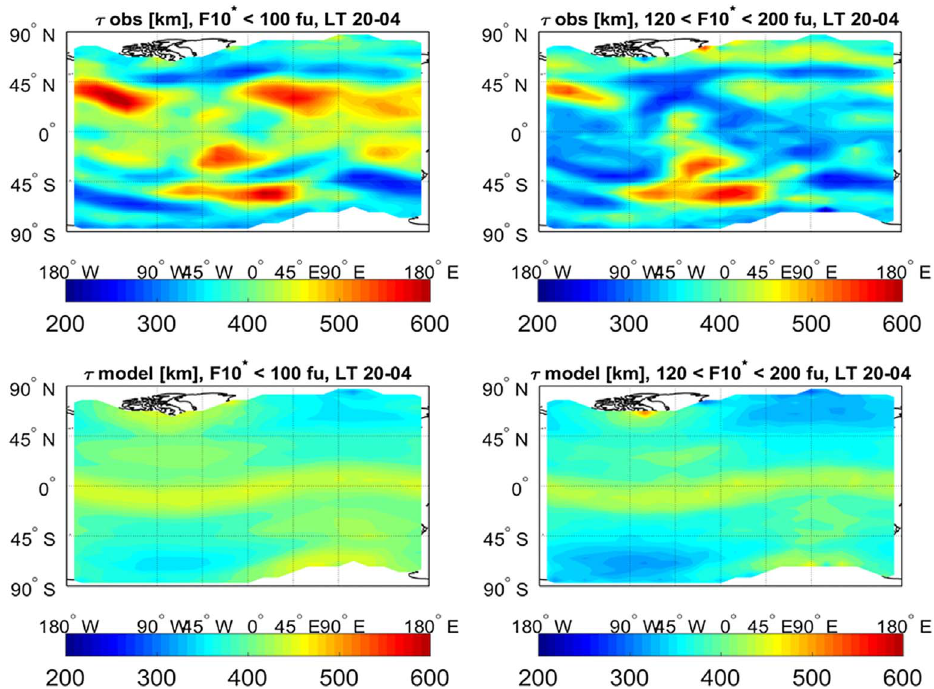
Fig. 8. Nighttime (20 – 04 LT) seasonally averaged global maps of observed (upper panels) and modelled s for LSA and HSA